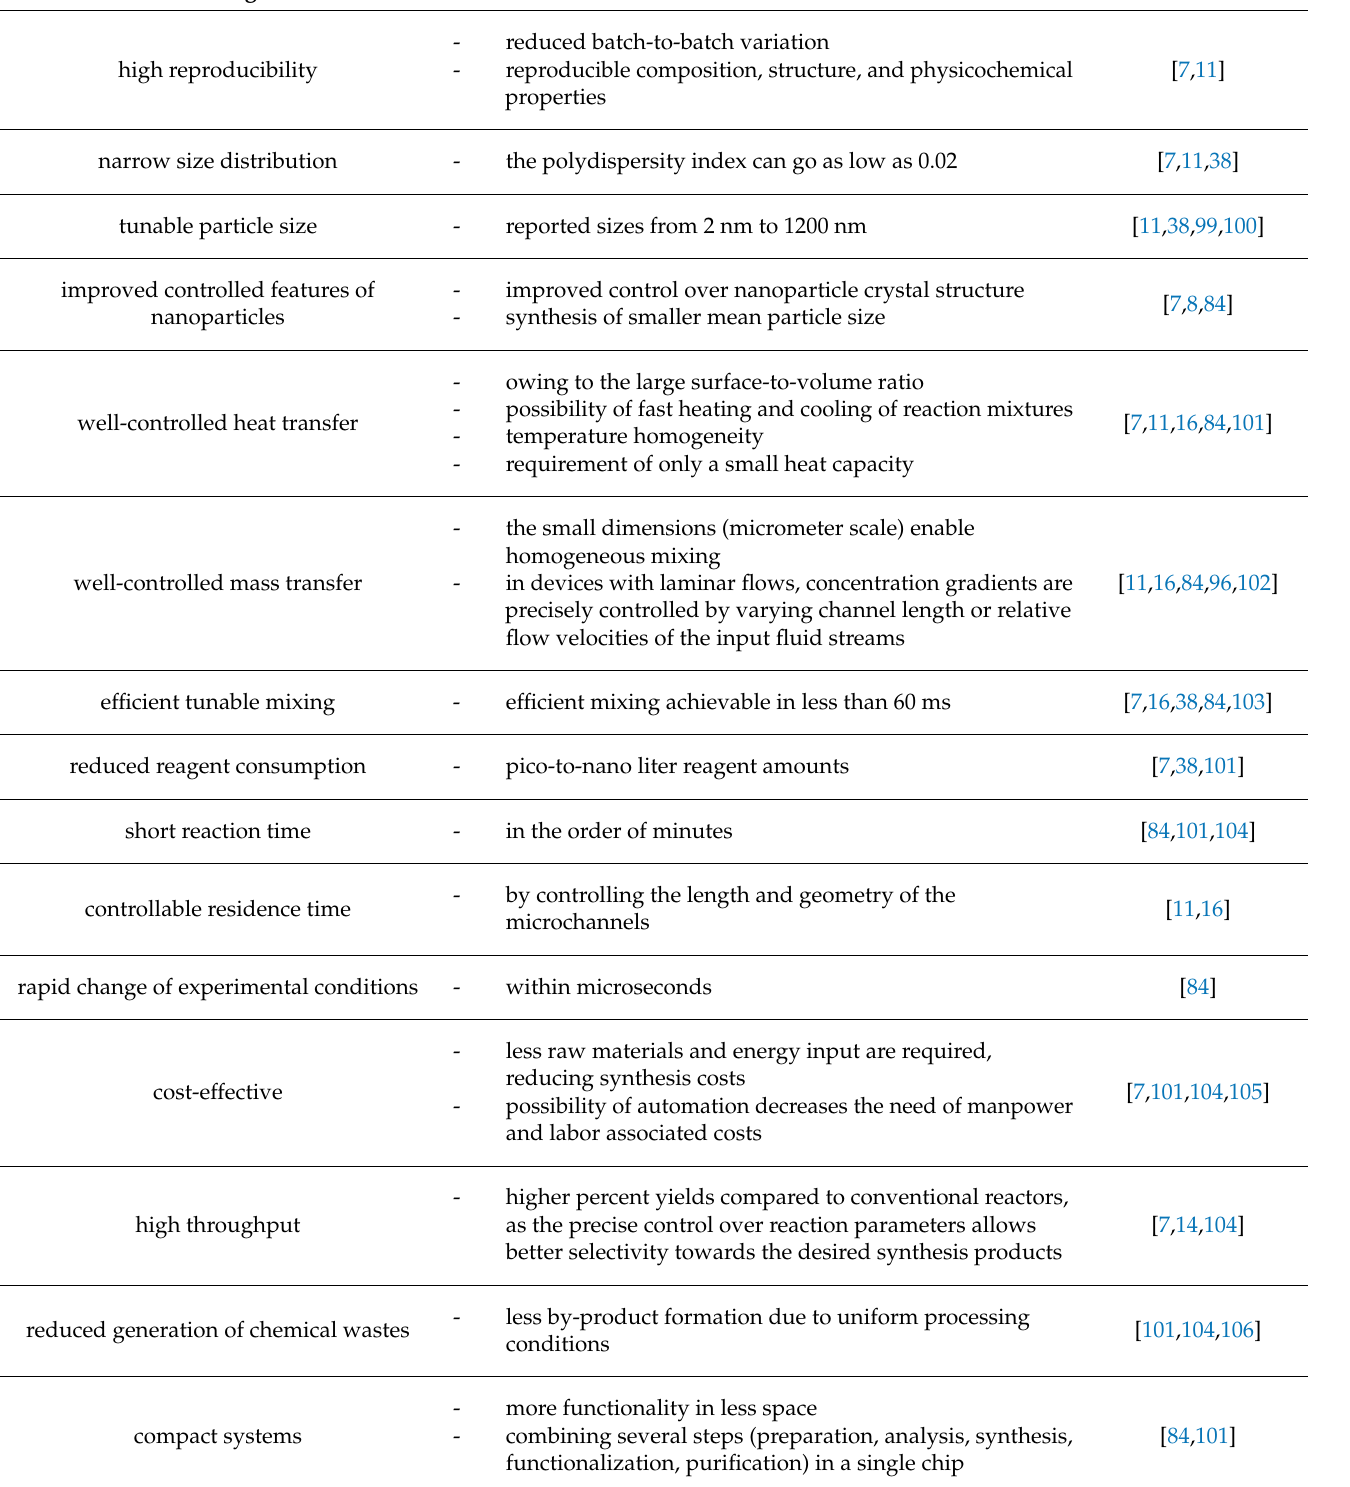
Table 2. Advantages of microfluidic systems